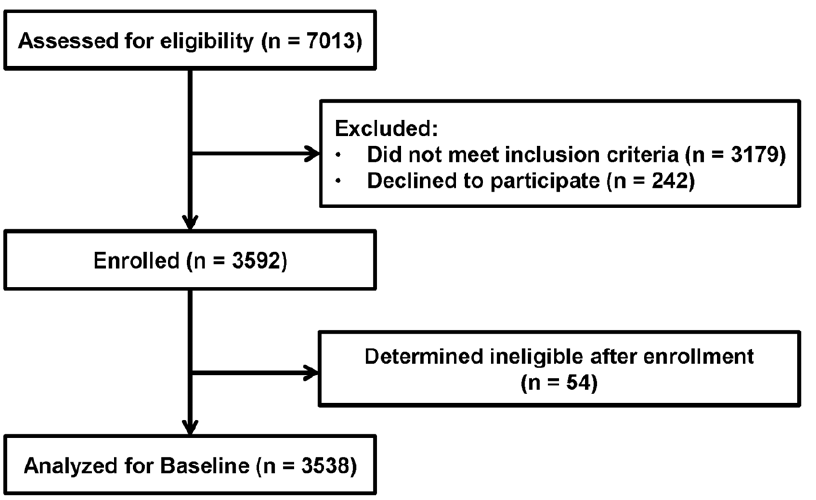
Figure 1. Flow diagram of patient participants in a group-randomized trial of prevention with people living with HIV in HIV care and treatment